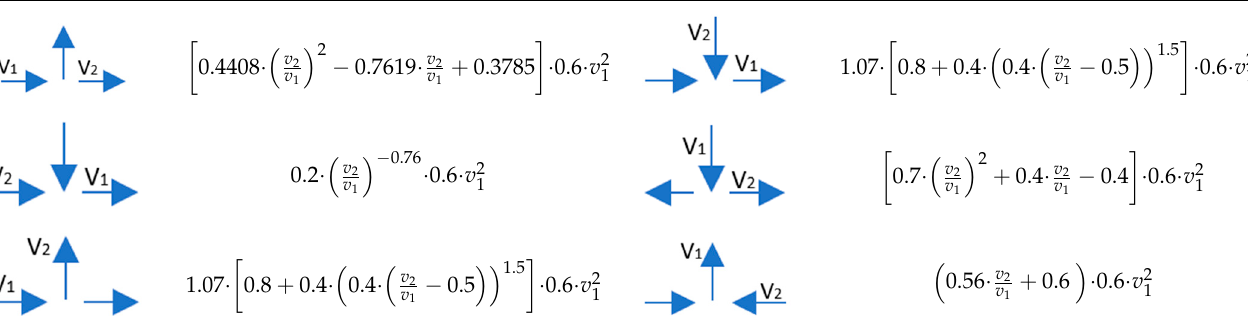
Table 3. Pressure drop equations for T connections.